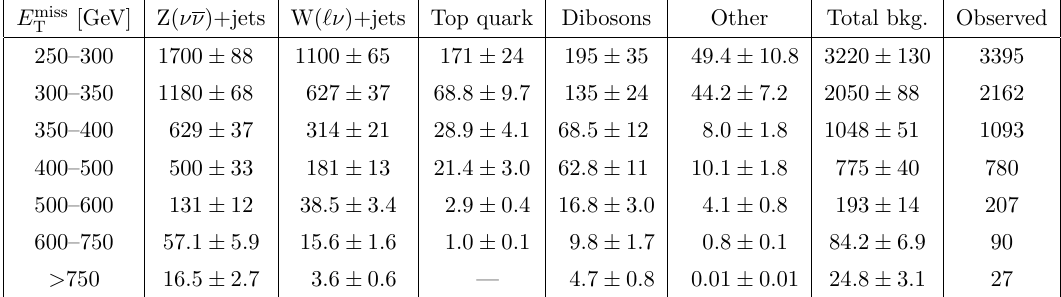
Table 4 . Expected event yields in each E miss